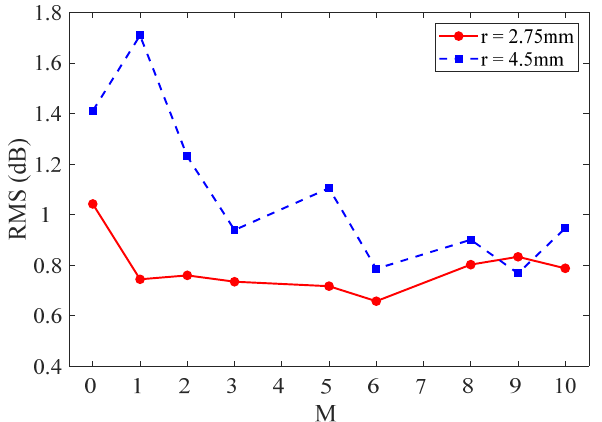
Figure 6. RMS as a function of different numbers of unit cell layers with different r sizes.